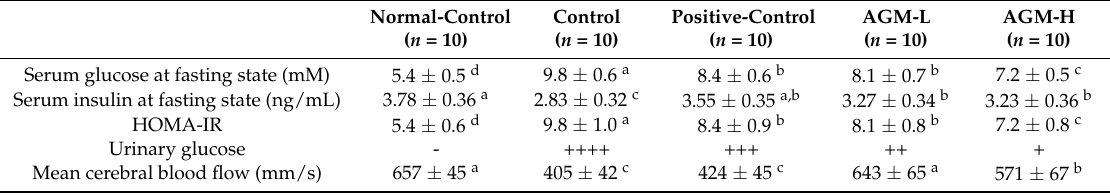
Table 3. Serum glucose and insulin levels at fasting states and insulin